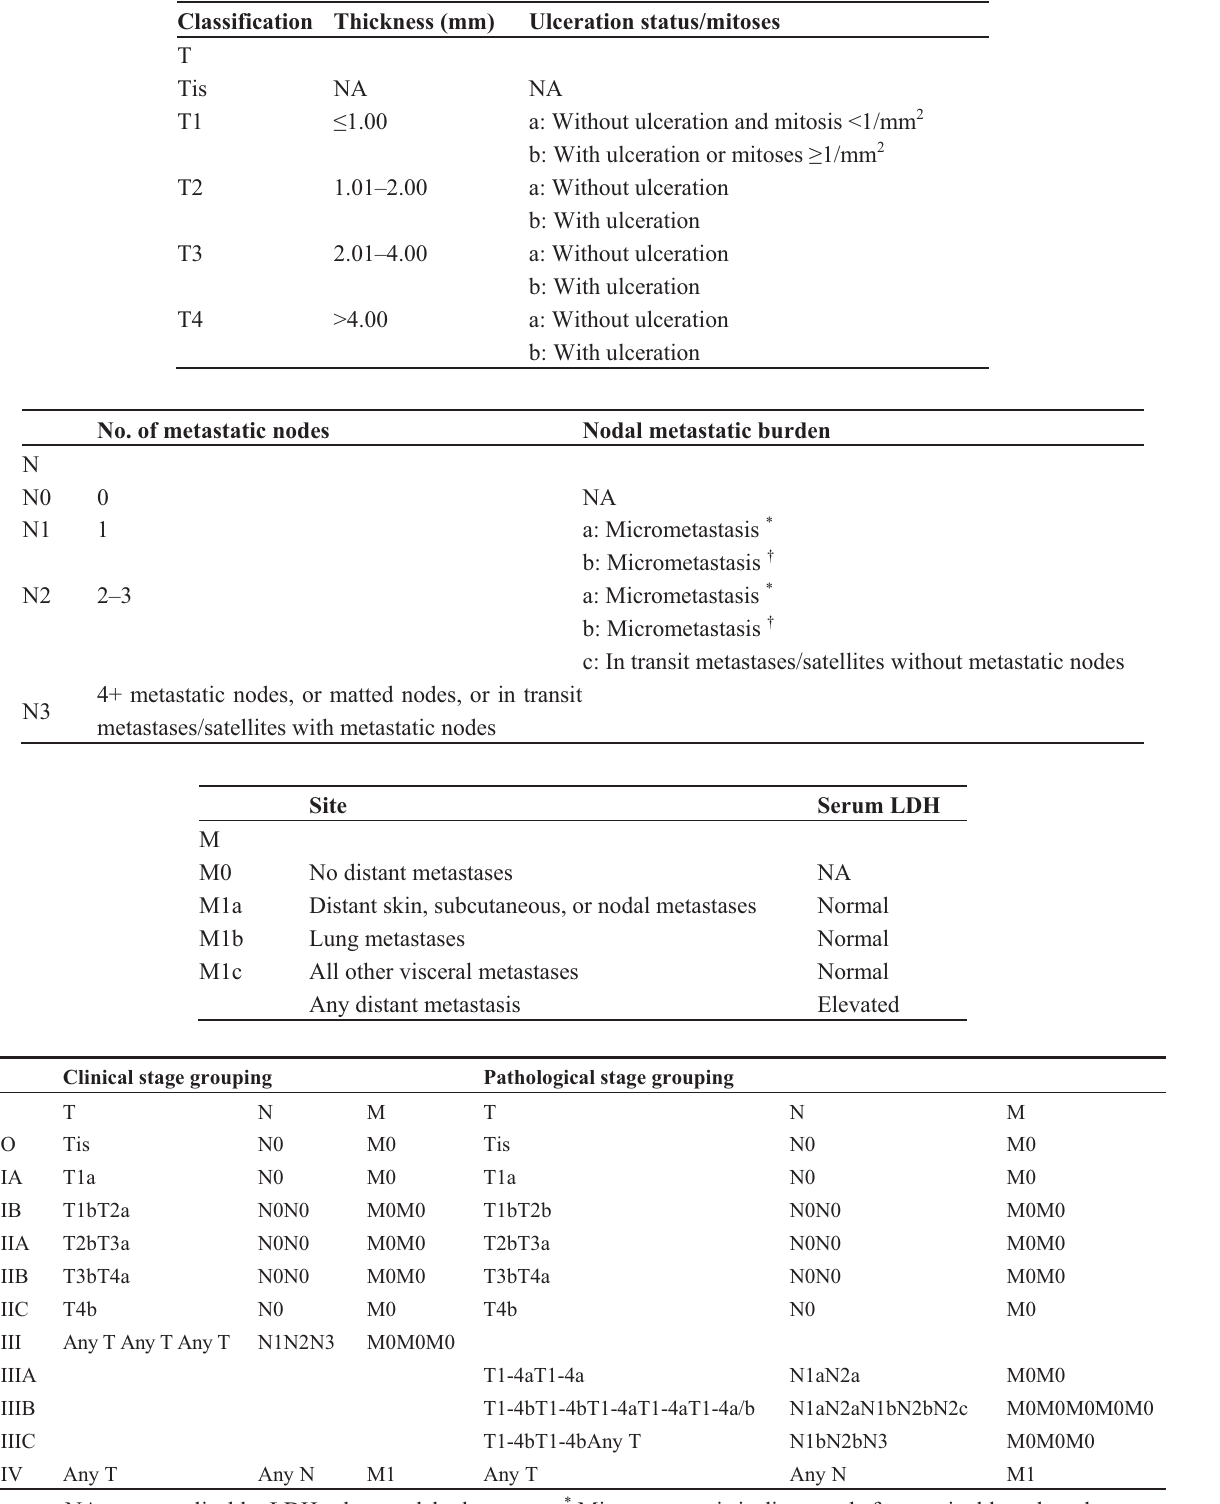
Table 4. Final version of 2009 AJCC melanoma staging and classification. TNM staging categories for cutaneous